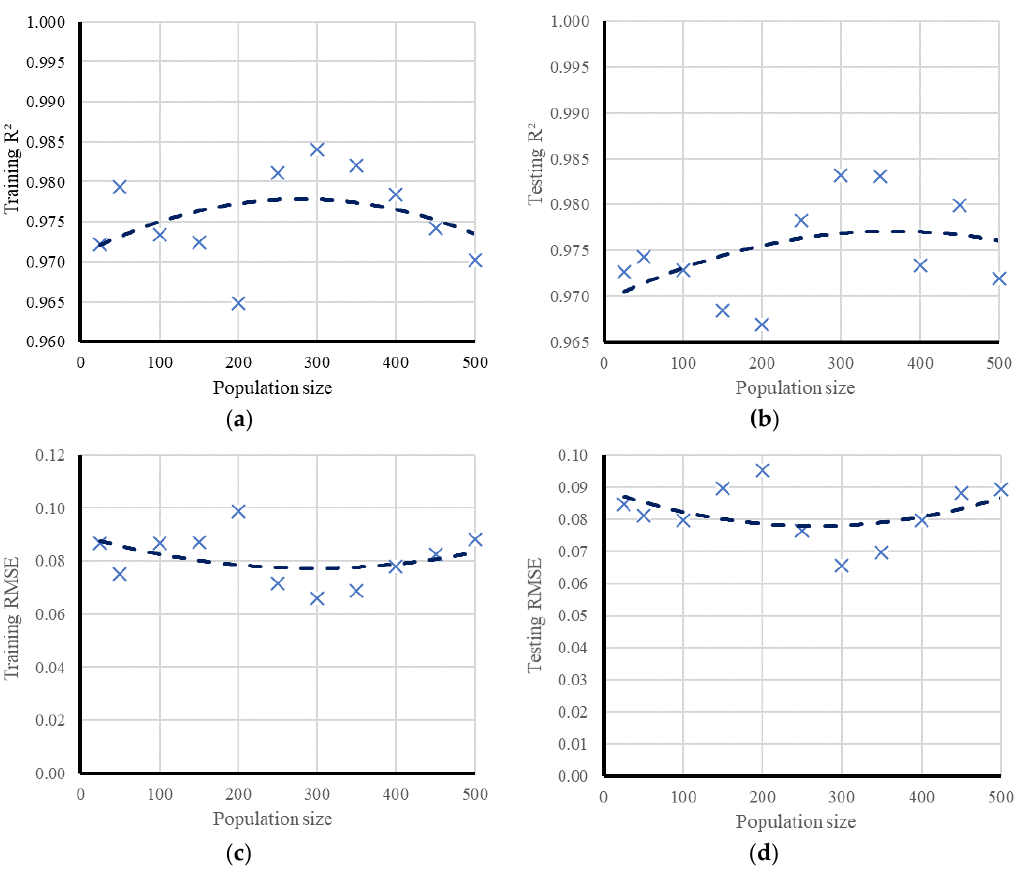
Figure 11. The results of network performance for the ICA – ANN vs. population size, ( a ) training R 2 ,